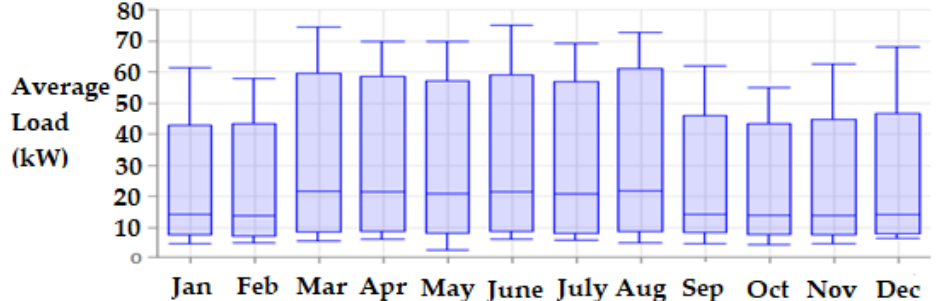
Figure 2. Monthly average scaled load profile for January–December.